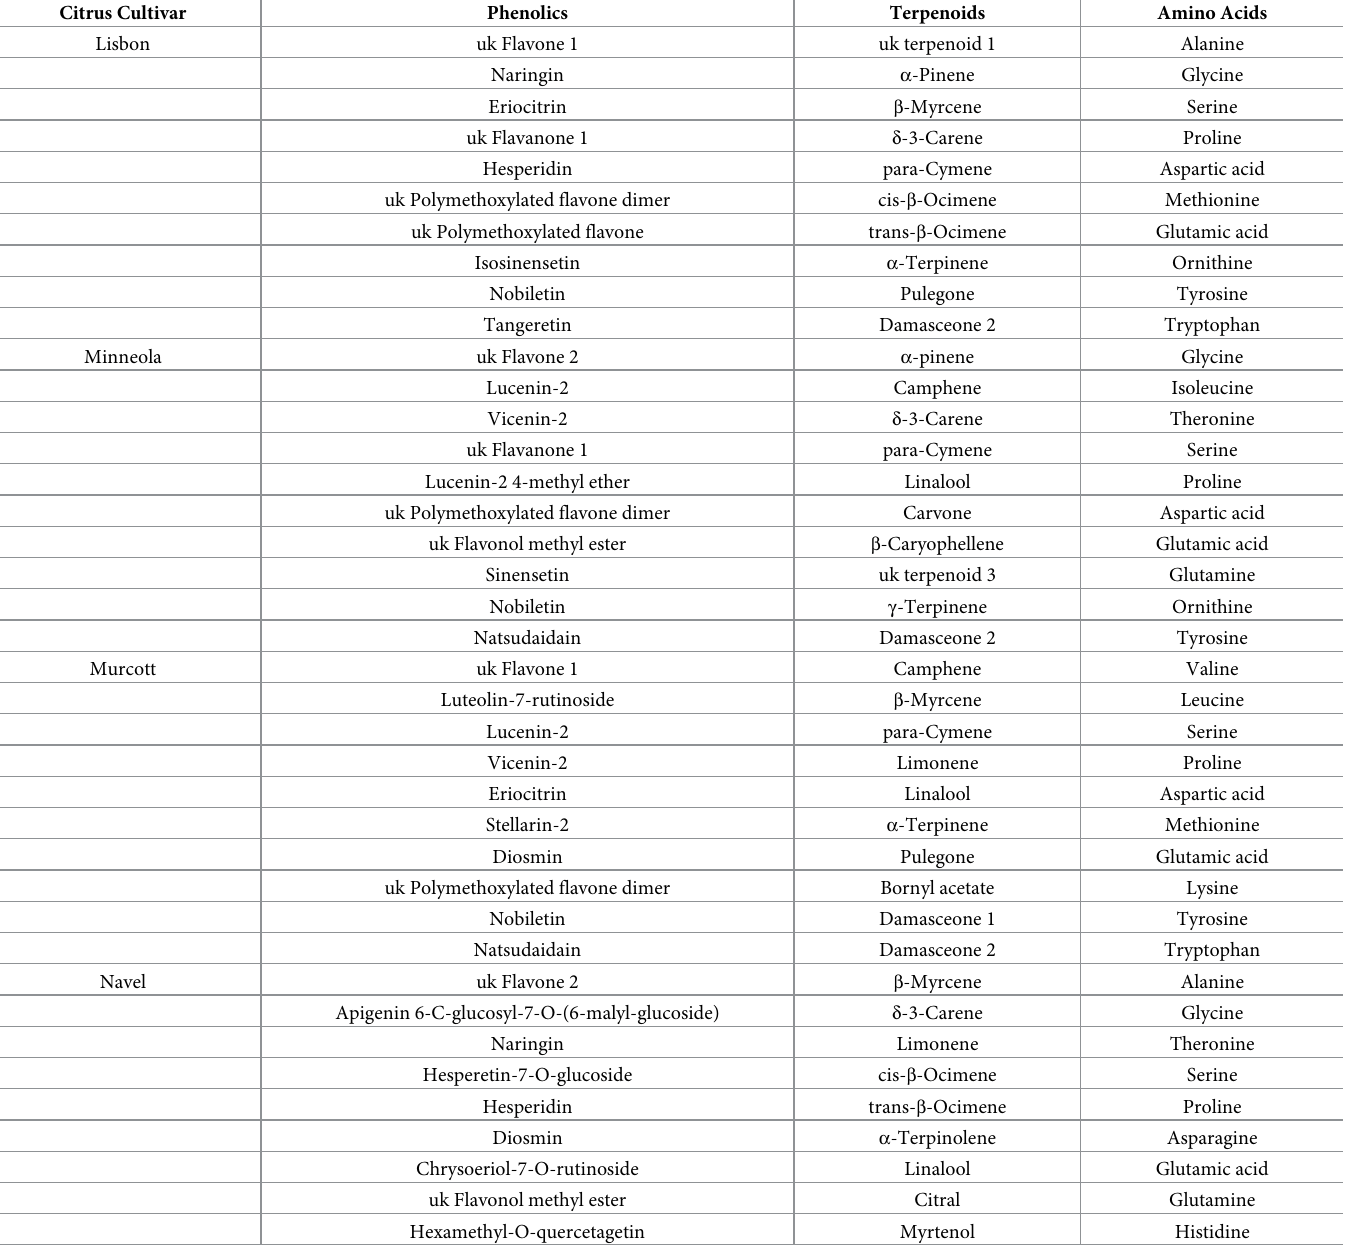
Table 2. Ten most variable phenolics, terpenoids, and amino acids identified in CDA. Citrus Cultivar